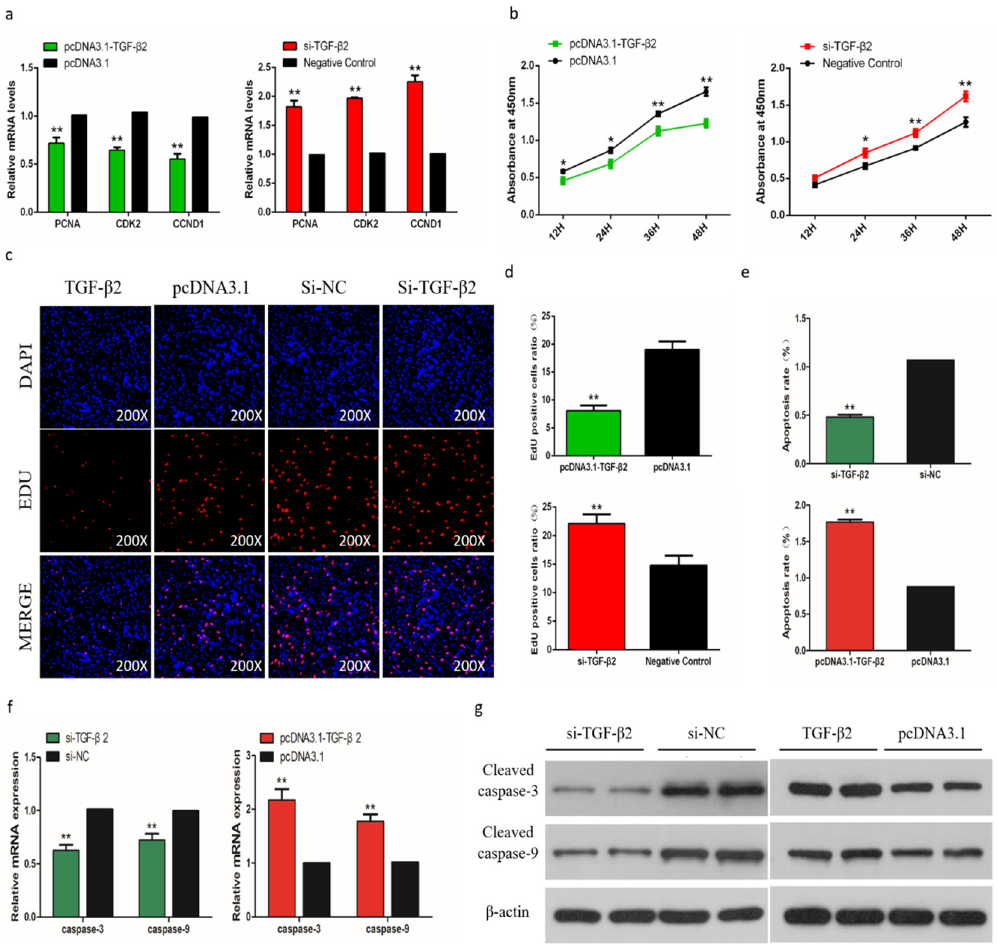
Figure 9. Effects of TGF- β 2 on apoptosis of skeletal muscle satellite cells (SMSCs). ( a , b ) Scattergram and the rate of apoptosis in SMSCs transfected with promoting or inhibiting TGF- β 2 expression as analyzed using flow cytometry following staining with annexin V and PI. ( c , d ) Abundance of mRNA and proteins of caspase-3 and caspase-9 in SMSCs transfected by the use of qPCR and Western blot analysis. Data are expressed as mean ± SEM ( n = 3). * p < 0.05; ** p < 0.01 vs. NC.